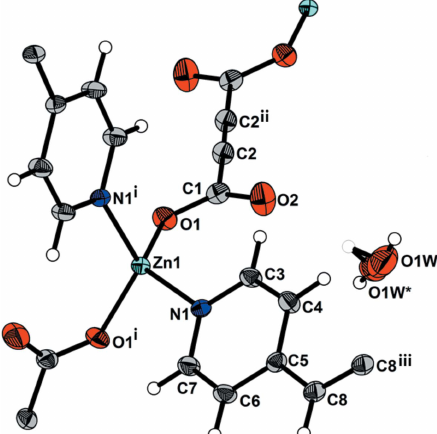
Figure 1 A fragment of the three-dimensional network of the title compound showing displacement ellipsoids at the 50% probability level. The disordered water solvate molecules are shown, and one of the H atoms is set to be exactly shared between the two water molecules. [Symmetry (cid:4) z ; (ii) (cid:4) x , (cid:4) y , 1 (cid:4) z ; (iii) 1 (cid:4) x , 5 (cid:4) y , 2 (cid:4) z .] codes: (i) (cid:4) x , y , 3 2 2 2